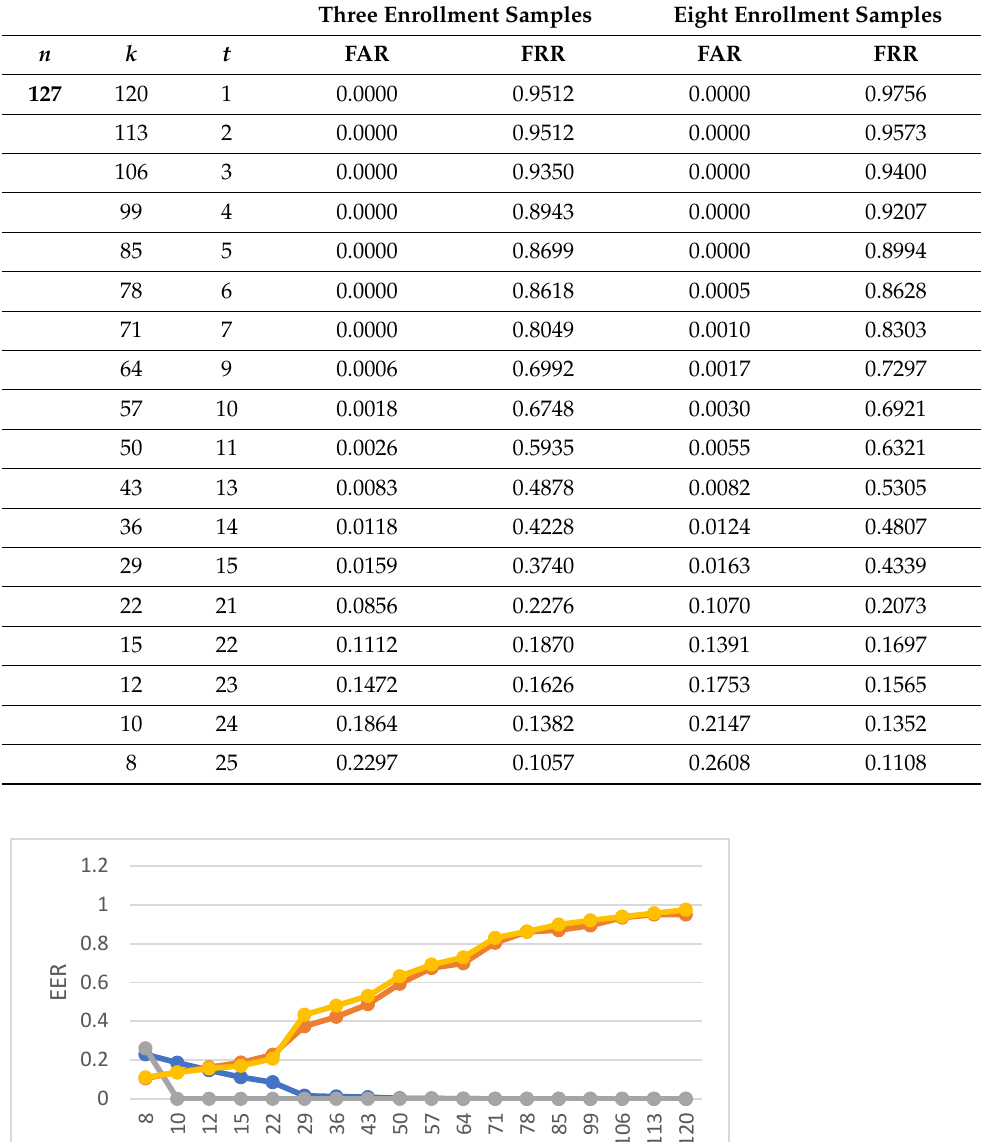
Table 3. The results of the first experiment with the Touchalytics dataset.